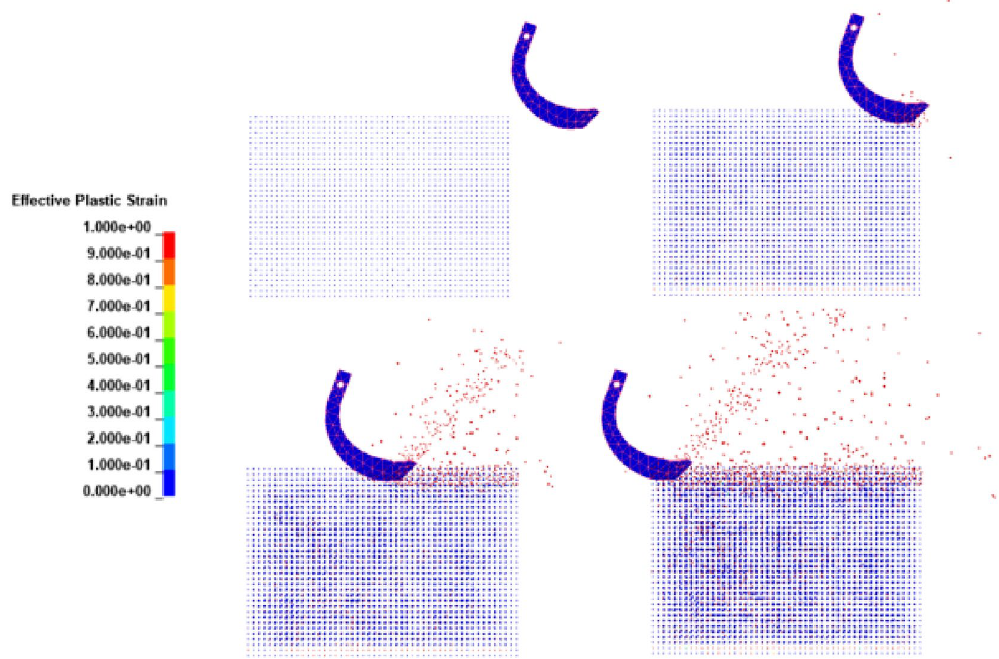
Figure 11. Cutting simulation process of FEM-SPH simulation